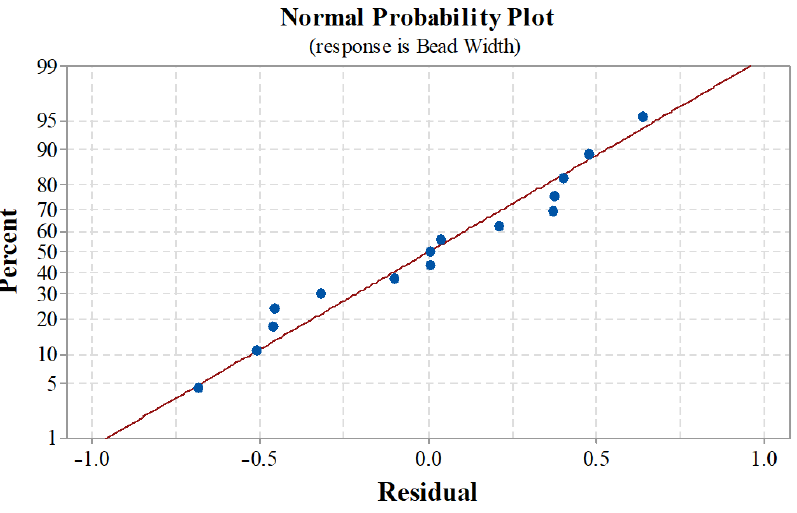
Figure 5. Normal probability plot for bead width.